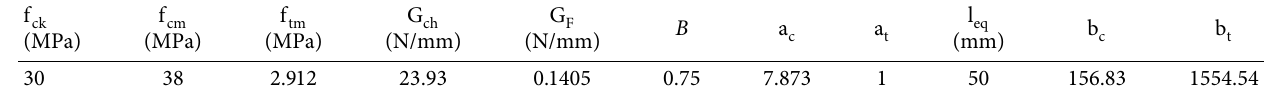
Table 4: Parameters of concrete damage-plastic [1].